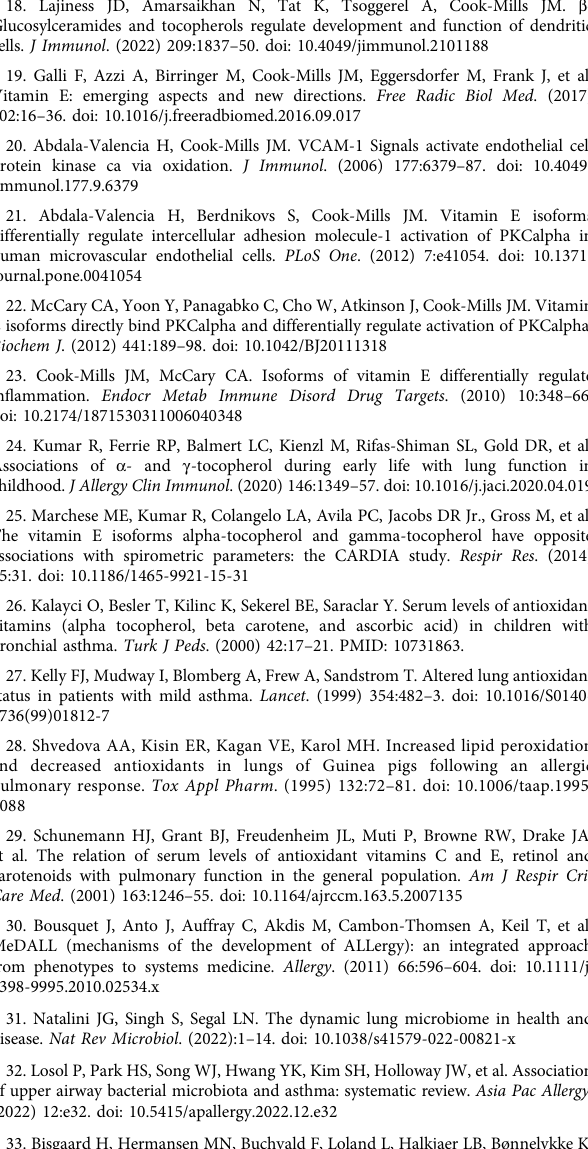
with α T-supplemented